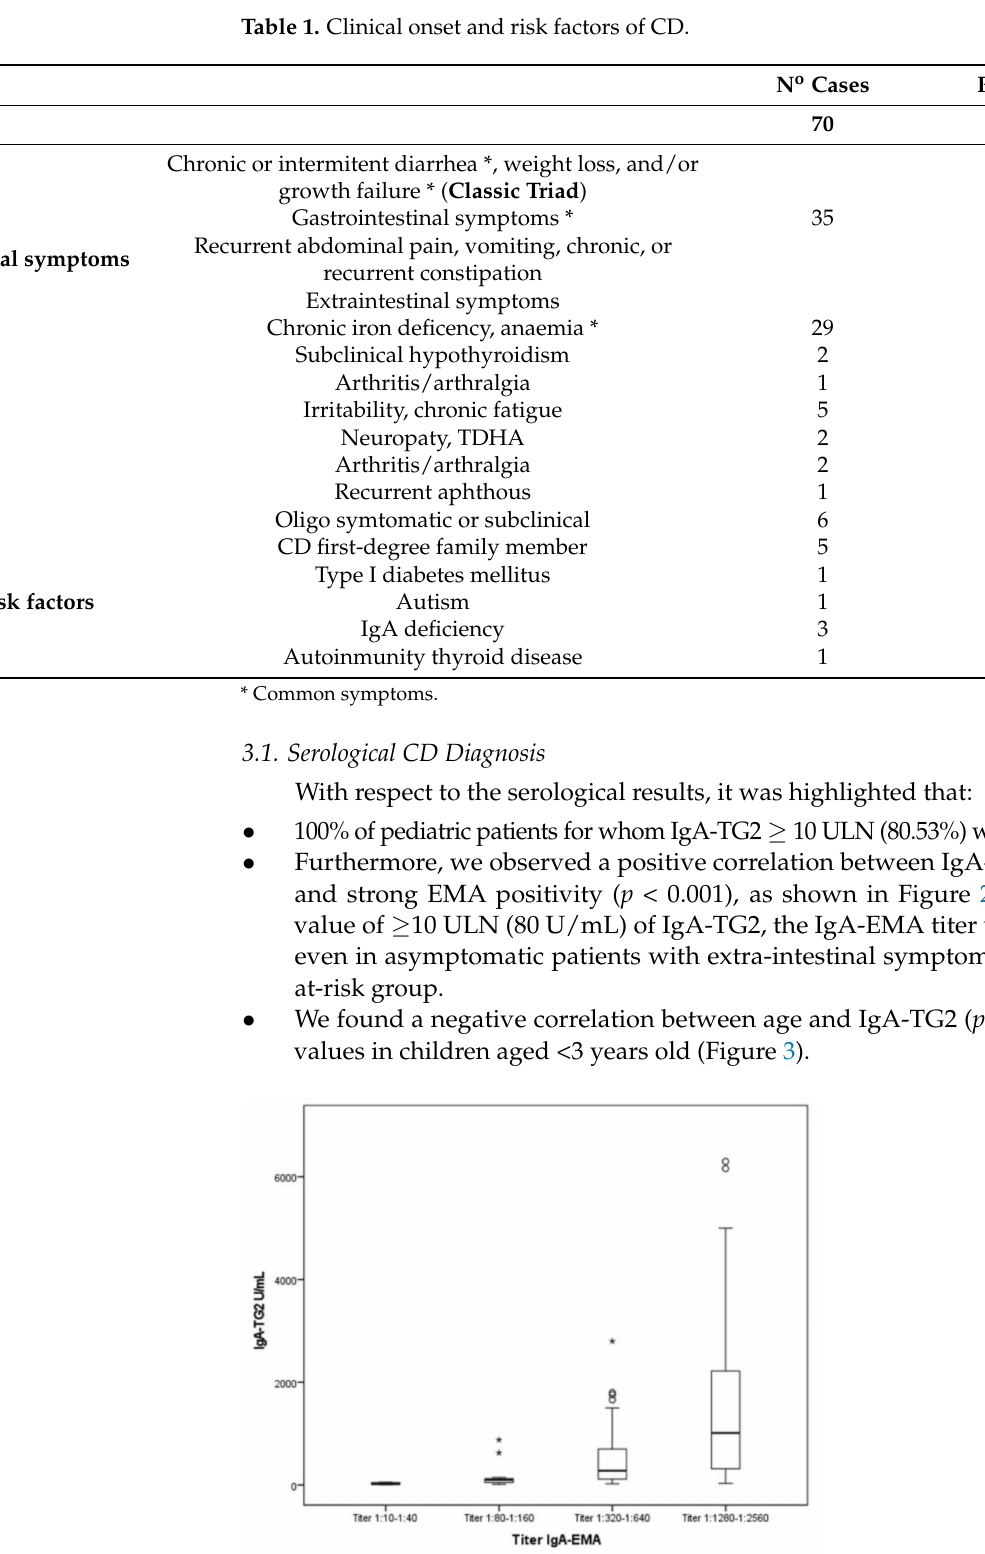
Figure 2. Relationship between IgA-TG2 and EMA titers. A non-parametric test comparing the medians among four groups of EMA. p < 0.001. Abbreviations: IgA-EMA, IgA anti-endomysial antibodies; IgA-TG2, IgA antibodies against tissue transglutaminase Type 2. ◦ Outliers are values between the IORs and three IORs from the end of a box. * Values more than three IORs from the end of a